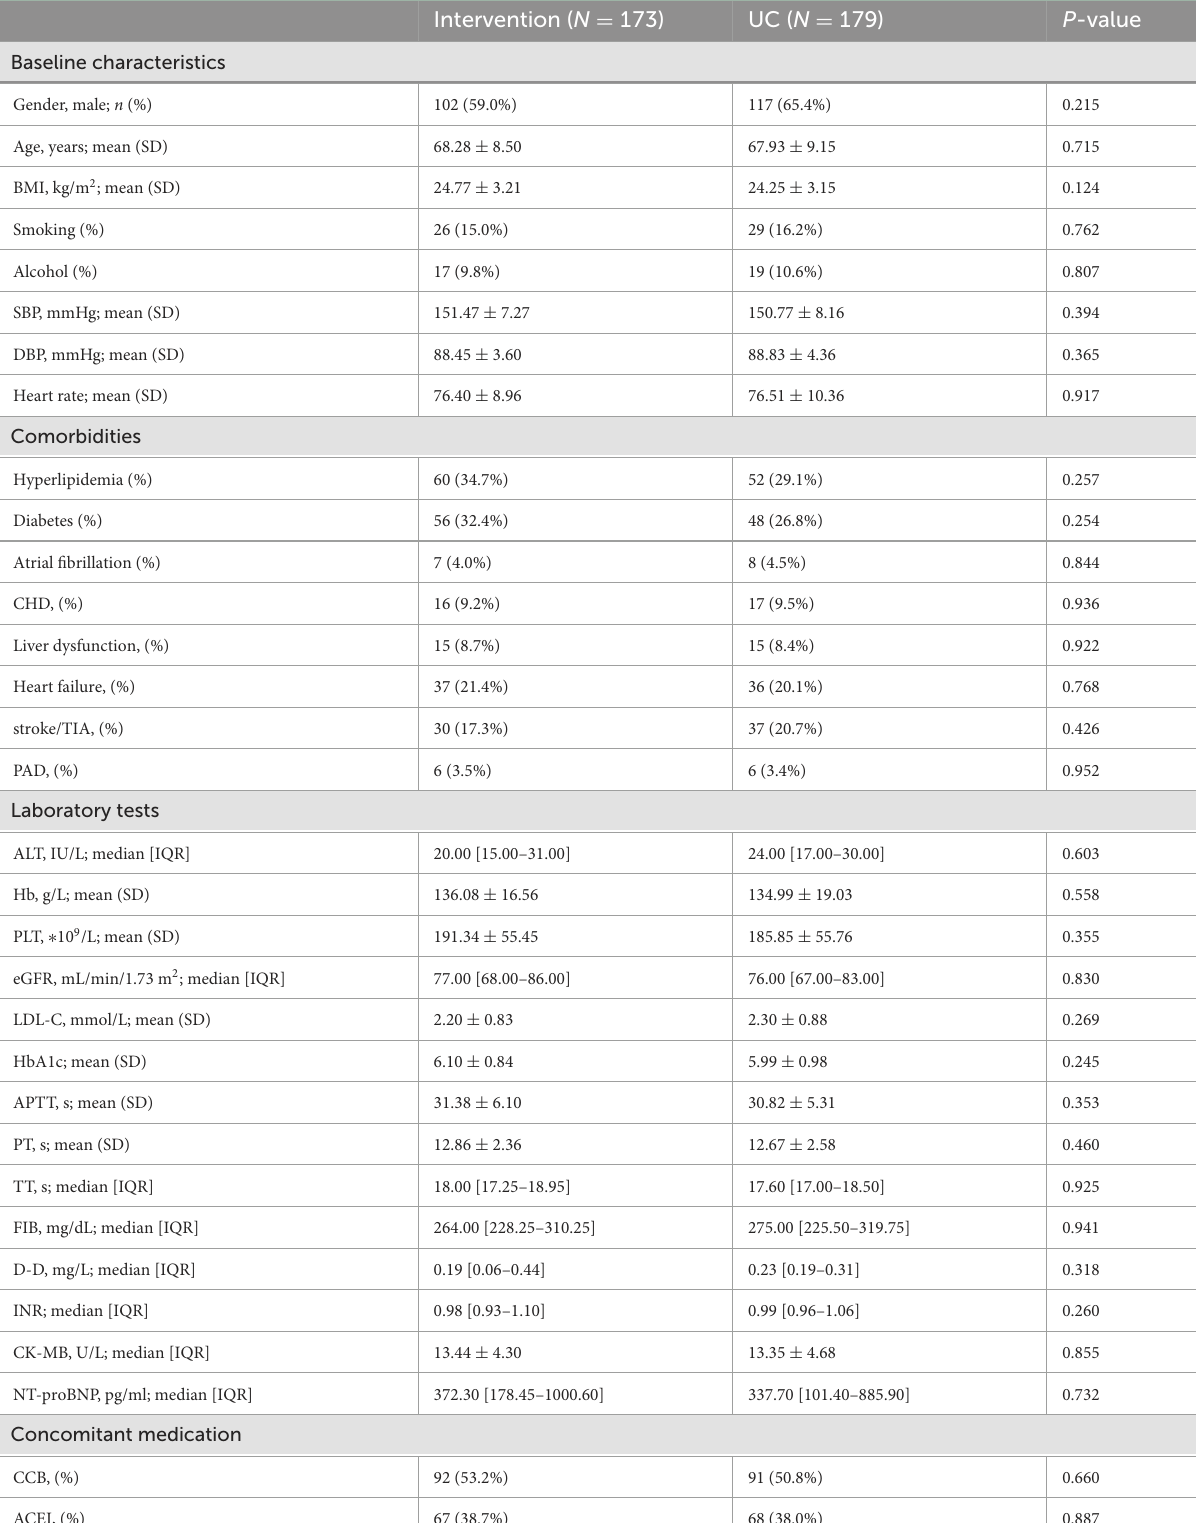
TABLE 1 Baseline demographic and clinical factors between intervention and UC groups. Intervention ( N = 173) UC ( N = 179) P -value Baseline